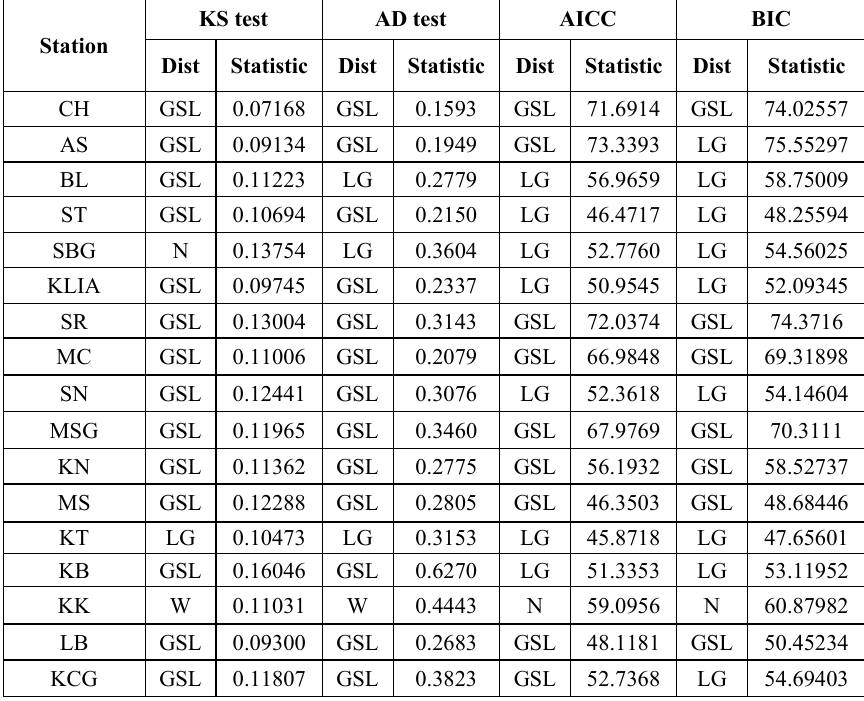
Table 3. The most preferable probability density function by each model selection